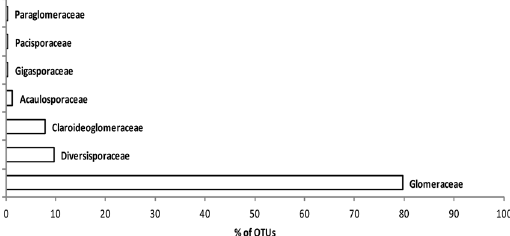
Figure 3. Incidence of Glomeromycotina in plant roots expressed as a percentage of OTUs (based on abundance of OTUs in samples) for particular AMF